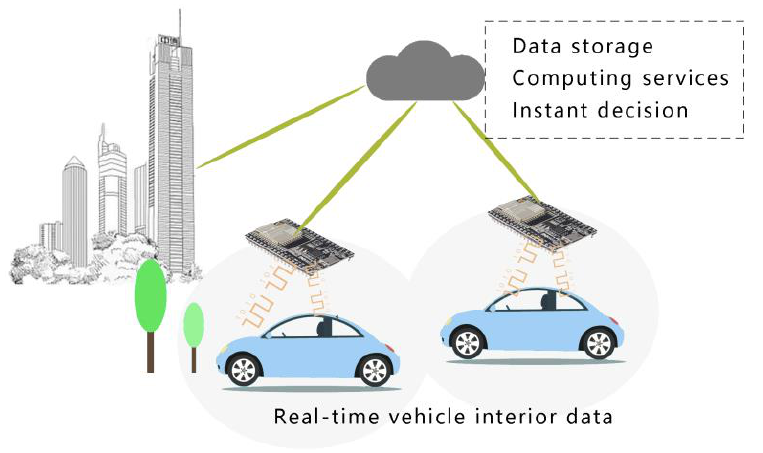
Figure 3. AIOT of Figure 3. AIOT of ESP32.